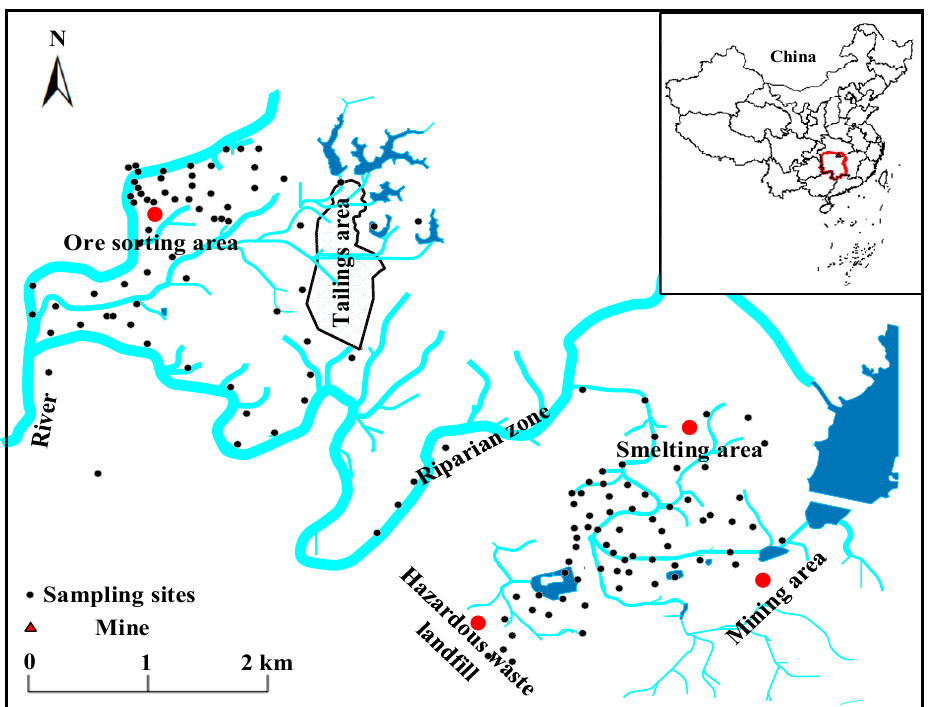
Figure 1. Study area and sampling sites.